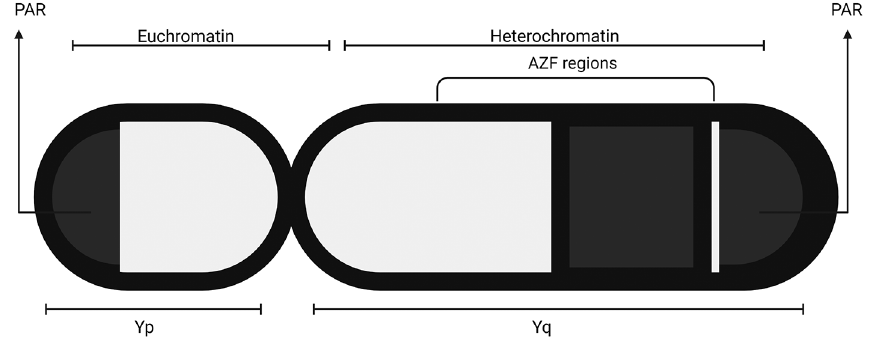
Figure 3. Diagram of the Y Chromosome. The Y chromosome is an acro-centric form of chromosome, with its centromere located severely off the center. It is divided into the long arm (Yq) and the short arm (Yp). The Yp and the proximal part of the Yq forms the Euchromatin, also known as the Yq11, and the distal part of Yq forms the Heterochromatin (Yq12). The pseudoautosomal region (PAR) represent where the Y chromosome binds with the X chromosome, and the AZF regions are located on the Yq. It is important to note that the length of the hetero- chromatin with the former playing a role limited to pre-meiotic male germ cells and the latter on post-meiotic spermatids. Males who did not have the DBY gene exhibited either Sertoli Cell only Syndrome (SCOS) or severe hypospermatogenesis, suggesting the gene ’ s importance in spermatogenesis (Foresta et al. 2000, Stanton et al. 2012). The functional genes seen in AZFb include Ribosomal protein S4, Y linked (RPS4Y2), which is expressed in the testis and prostate (Stahl et al. 2012). It plays a vital role in post-transcriptional regulation of the spermatogenic process. The Heat Shock Transcription Factor, Y linked (HSFY), exists as two coding copies in AZFb, HSFY1 and HSFY2. HSFY is predominantly present in the nuclei of round spermatids and is also associated with spermatogenesis (Stahl et al. 2012). One of the most important genes located in the AZFb region with 6 copies is the Ribonucleic Acid Binding Motif, Y linked ( RBMY ) and it is